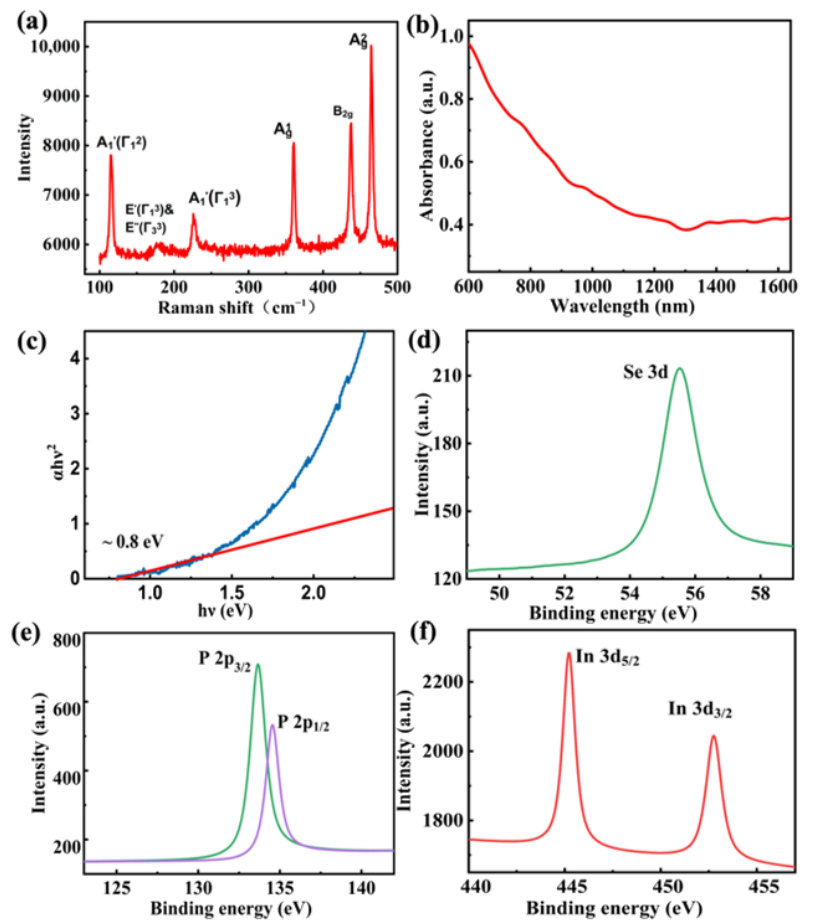
Figure 3. Characterization of the prepared 2D BP/InSe heterostructure. ( a ) Raman spectra. ( b ) UV- VIS-IR spectra. ( c ) Tauc plot of (αhν) 2 versus hν. ( d – f ) XPS spectrum of In, Se, and P, respectively. VIS-IR spectra. ( c ) Tauc plot of ( α h ν ) 2 versus h ν . ( d – f ) XPS spectrum of In, Se, and P,